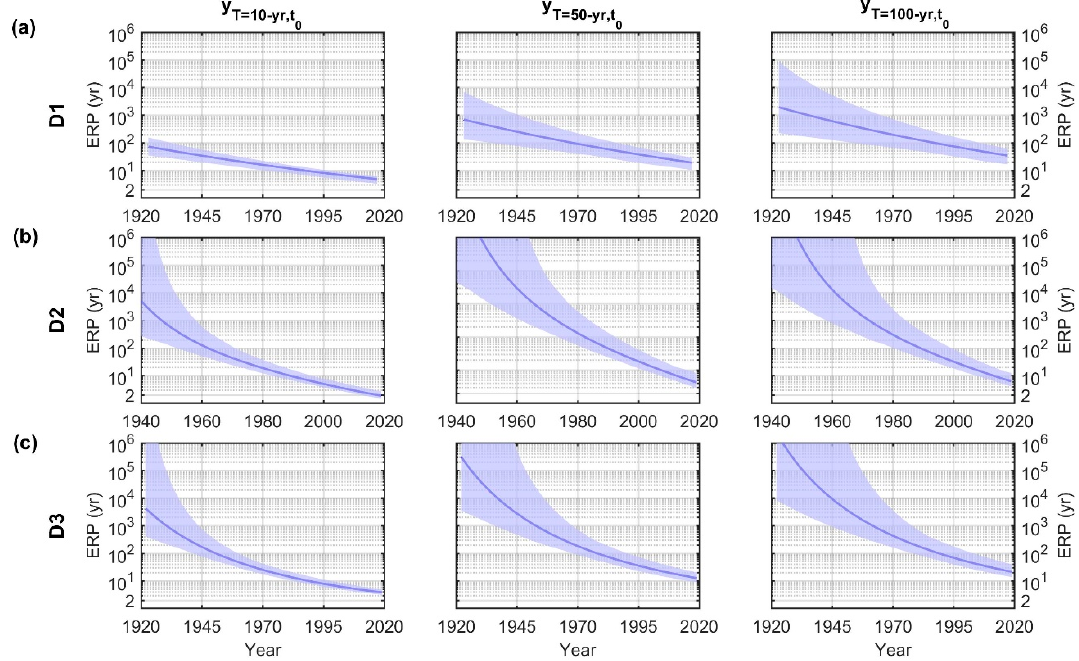
Figure 5. The point estimates of the effective return periods ( ERPs ) (blue lines) and their uncertainty (shaded areas) at the three selected assessment thresholds ( y p ) (the 10-, 50-, and 100-yr quantiles derived from the corresponding nonstationary model at the reference time t 0 = 30 years prior to the end of the observation period) for ( a ) D1, ( b ) D2, and ( c )